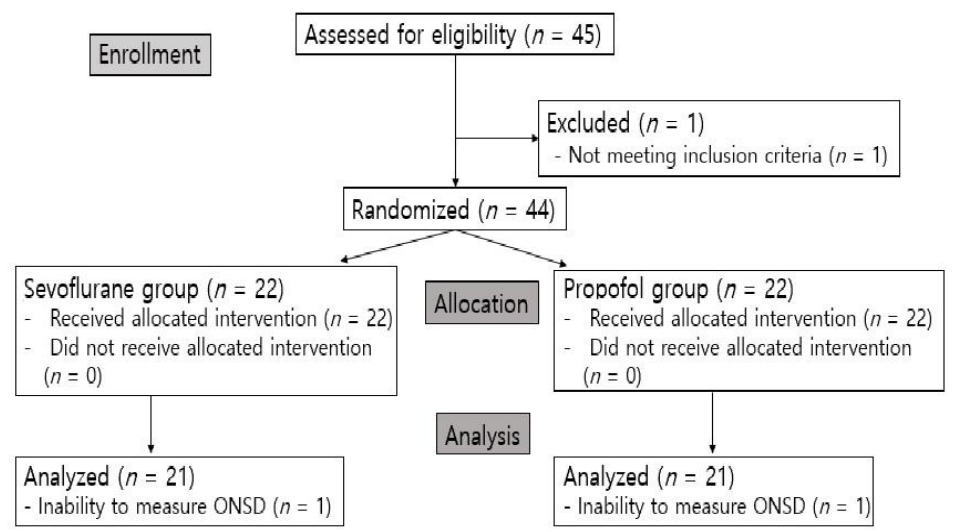
Figure 2. CONSORT flow gram. Table 1. Demographic and perioperative data.